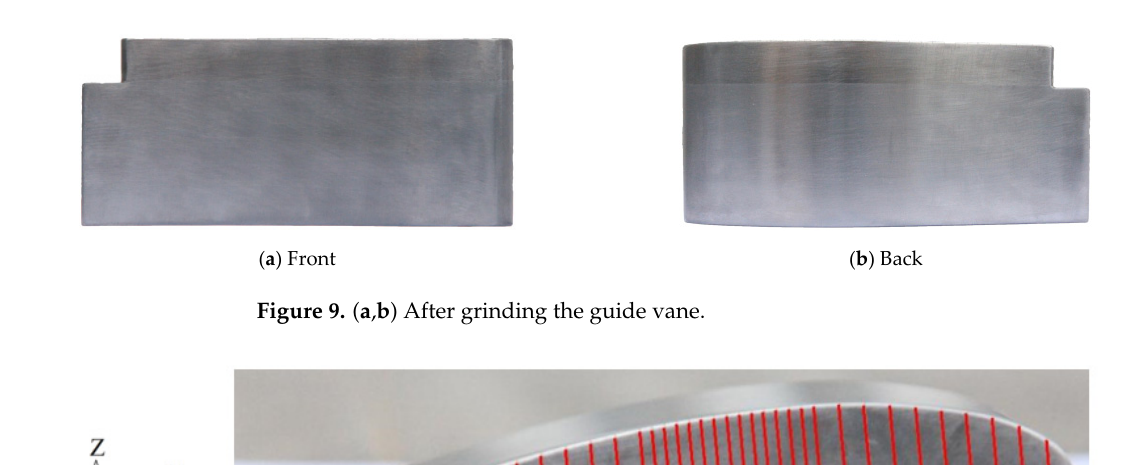
Figure 11. White light interference profiler.